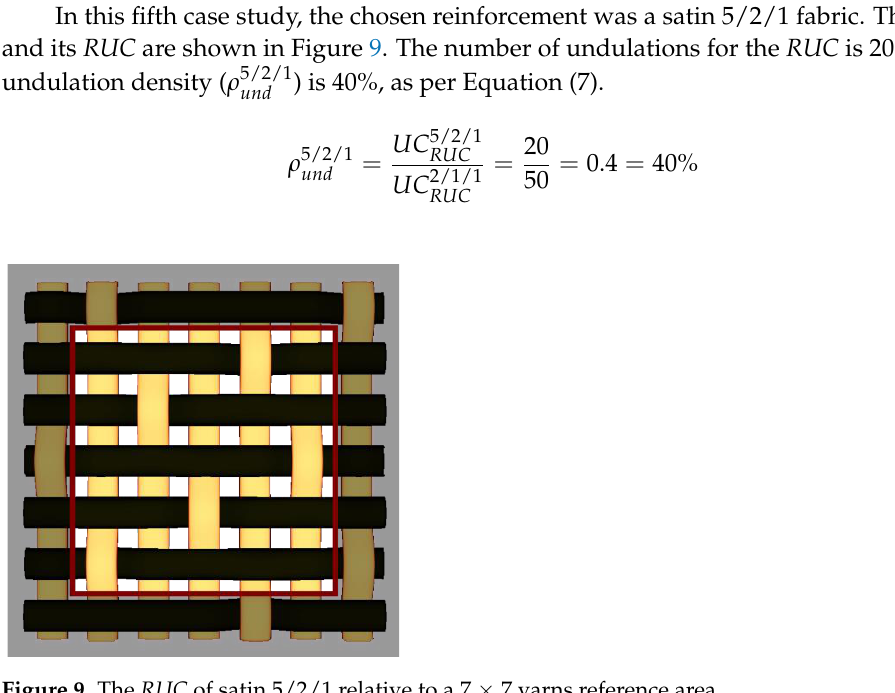
Figure 9. The RUC of satin 5/2/1 relative to a 7 × 7 yarns reference area.